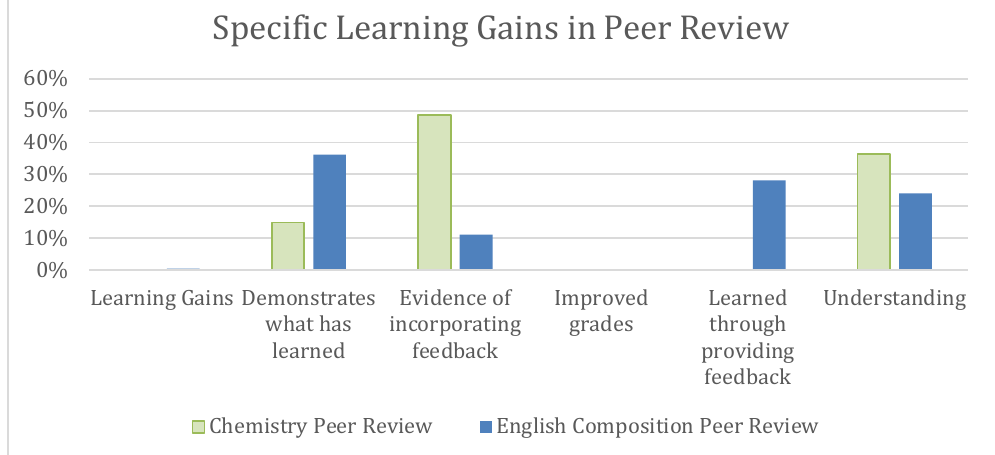
Figure 9 . Specific learning gains in peer